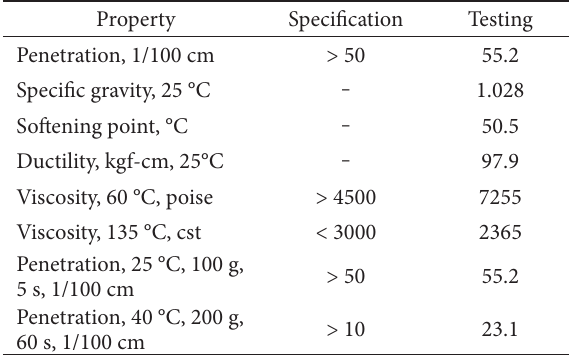
Table 2. Th e properties of modifi ed asphalt cement